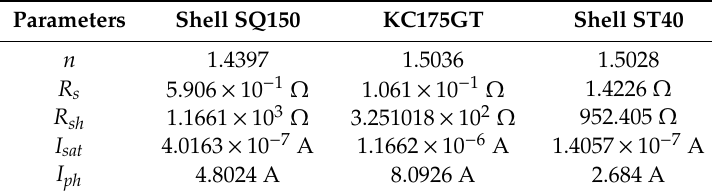
Table 3. Estimated values of the parameters of the test PV module.